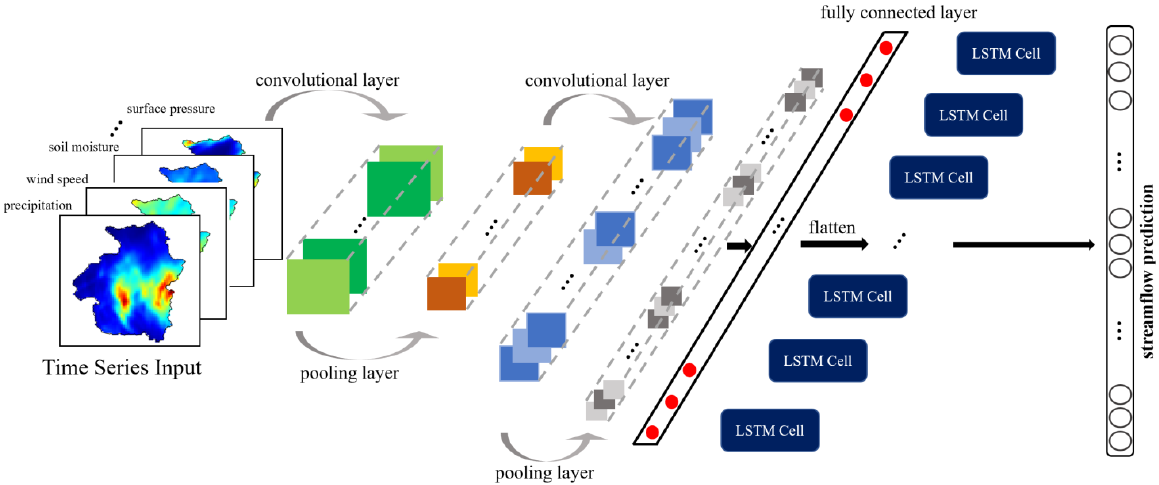
Figure 2. Structure of the convolutional neural network (CNN) integrated with the long short-term memory (LSTM) network used in this study [52].